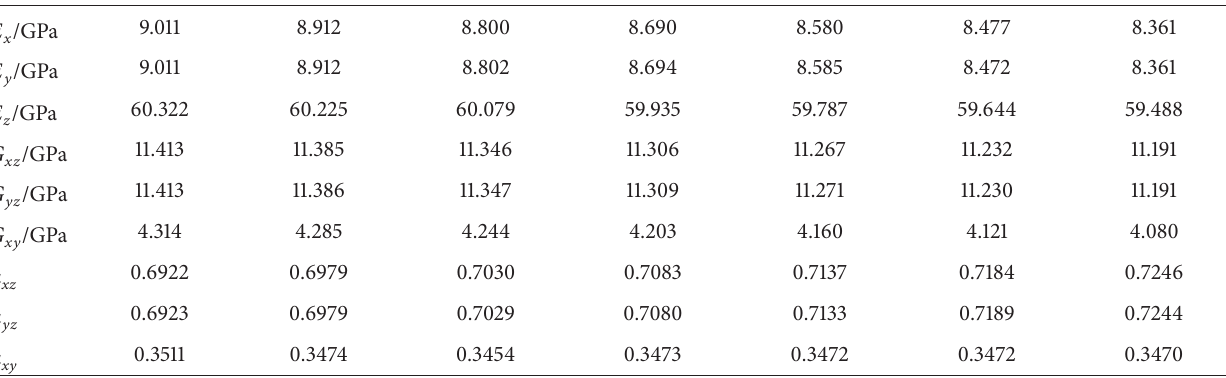
Table 5: Effect of 𝑝 𝑦 V (or 𝑝 𝑚 V ) on the elastic properties of specimen number 1. Elastic